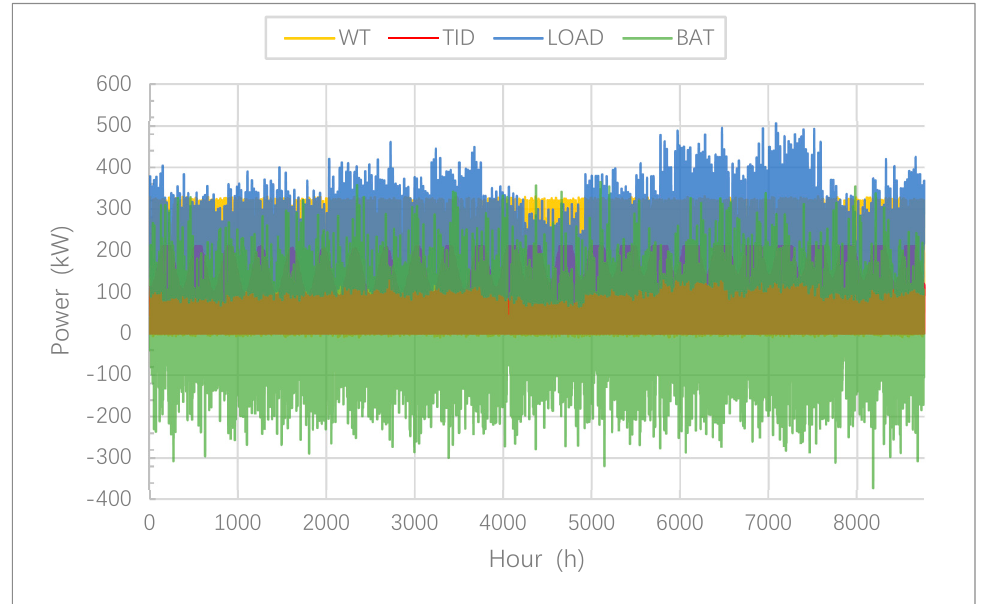
Figure 14. Annual electricity generation of renewable energy system.